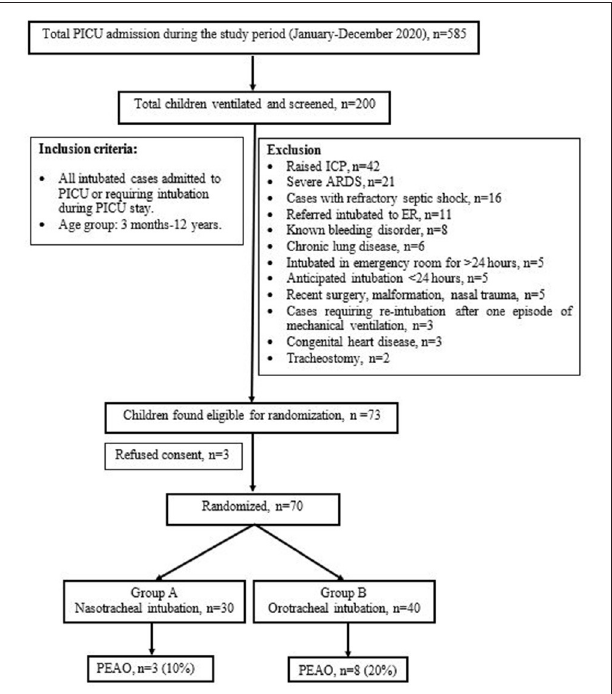
FIGURE 1 | Study flow